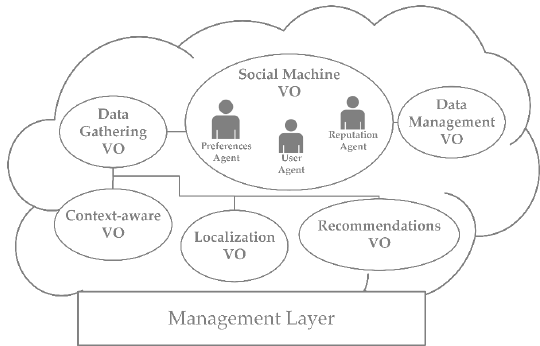
Figure 7. The social machine is supported by the VOs’ that manage the localization and tracking of users, the contextual information and the generation of recommendations which help foster good energy saving